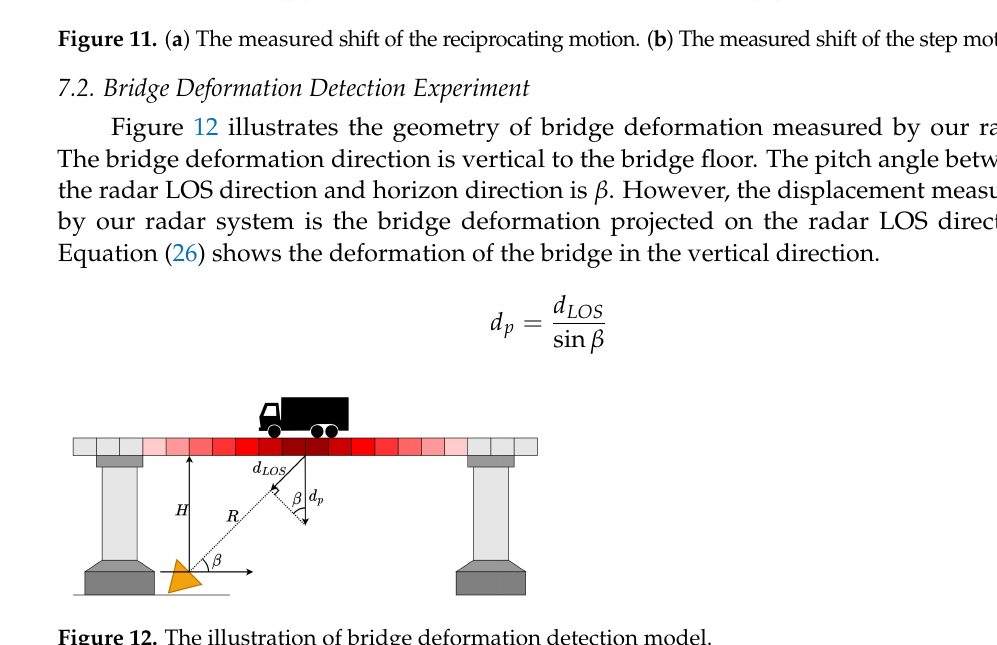
Figure 12. The illustration of bridge deformation detection